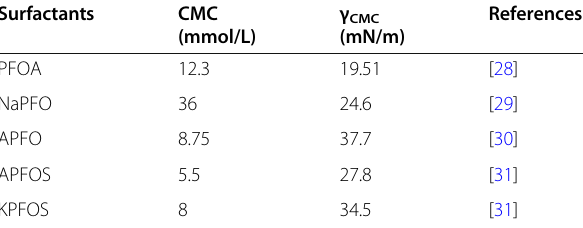
Table 1 CMC and γ CMC of some perfluorooctyl surfactants Surfactants